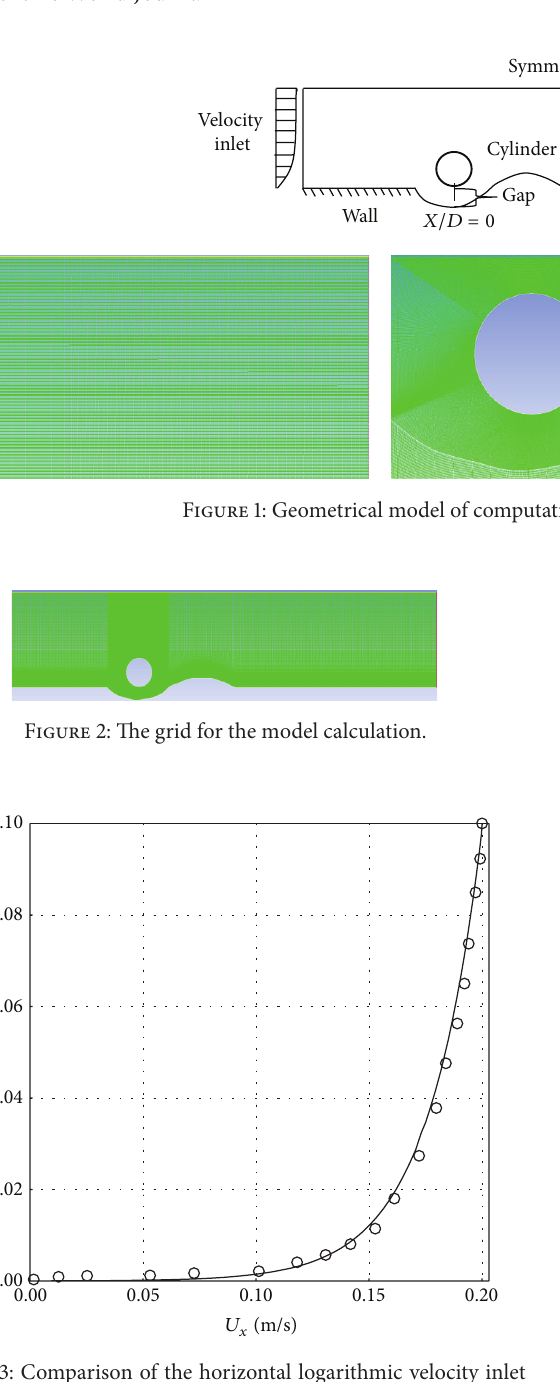
Figure 3: Comparison of the horizontal logarithmic velocity inlet ( 𝑈 0 ) in the total water depth between present numerical investiga- tion and experimental work of Dudley